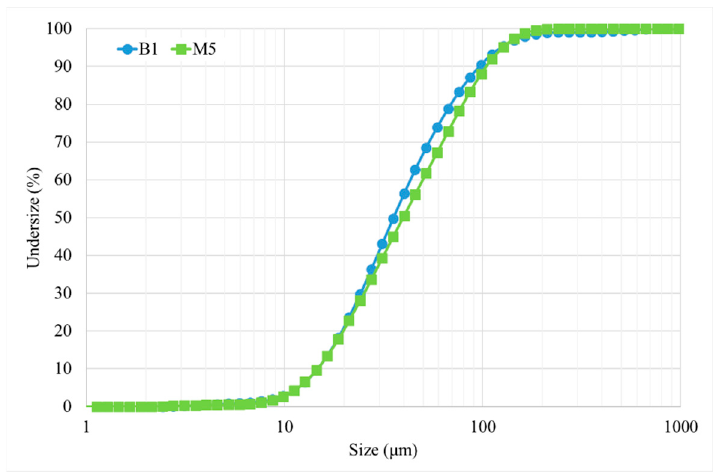
Figure 2. Particle size distribution of